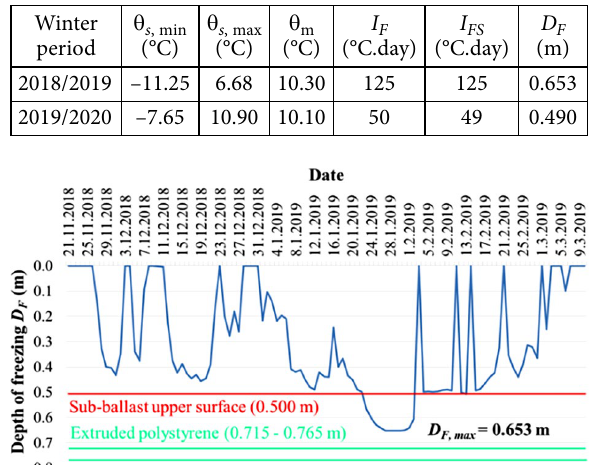
Figure 3. The course of freezing of the railway track structure – winter period 2018/2019 (measuring profile no.